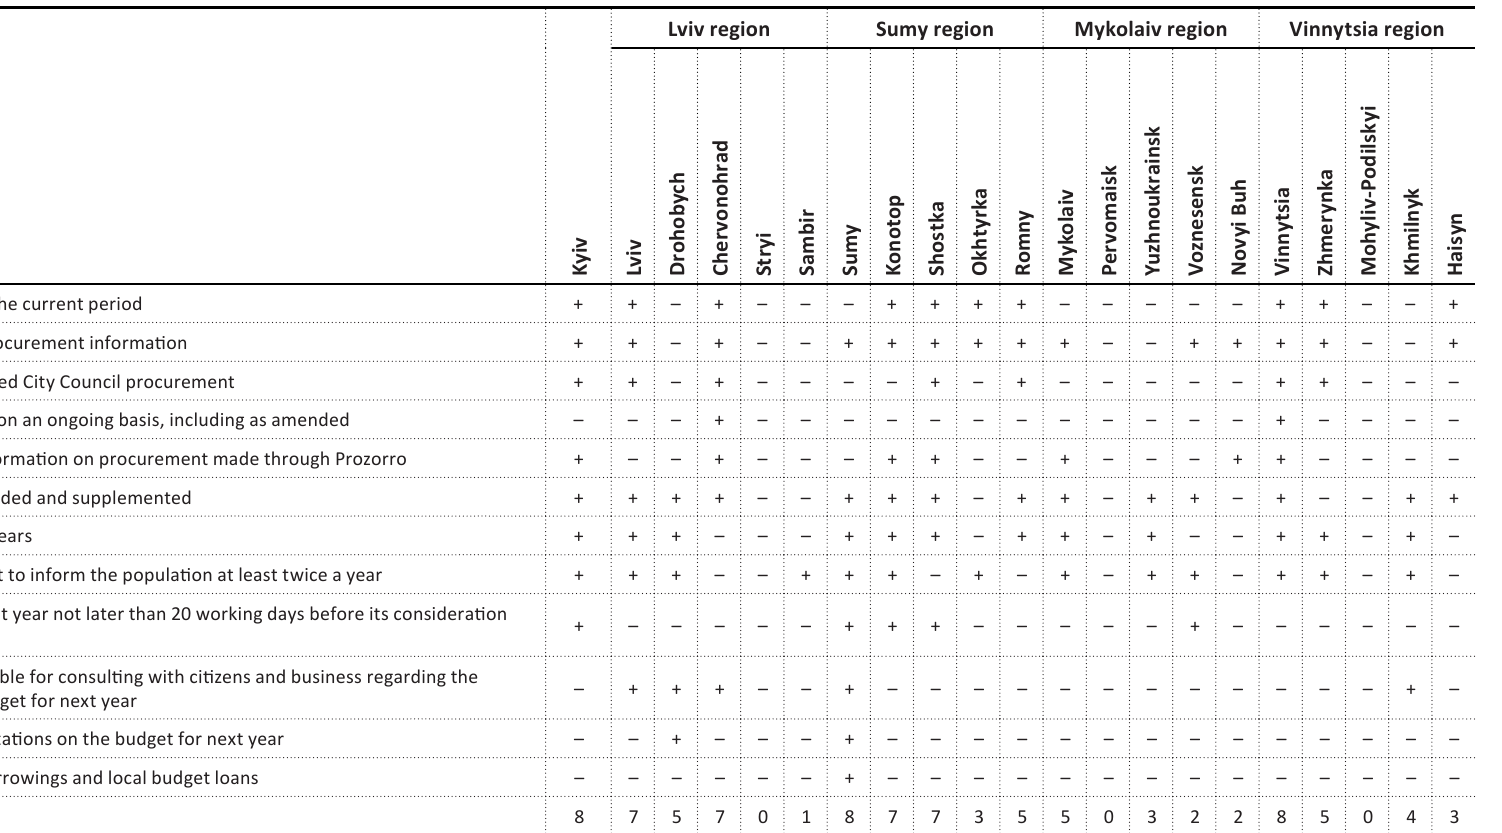
Table 1. The survey results of the transparency of city council sites by region